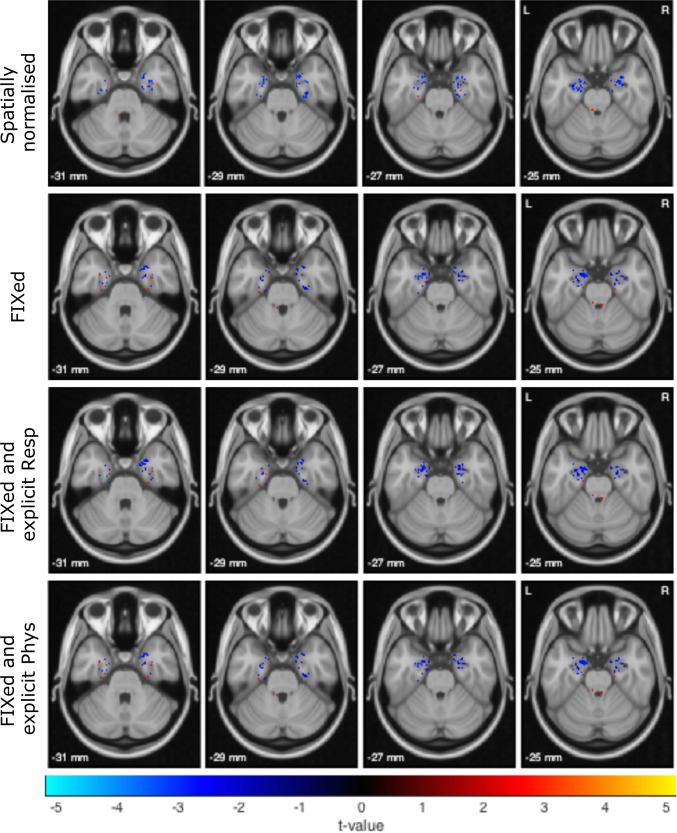
Functional connectivity from LC to MTL during consolidation compared to baseline across preprocessing steps.Note: Functional connectivity (FC) from LC component to medial temporal lobe regions during consolidation compared to baseline across preprocessing steps (t-values threshold at p<0.05, uncorrected for multiple comparisons). Significant clusters of lower FC between the LC and hippocampus and amygdala during consolidation as compared to baseline were observed across preprocessing steps except for the spatially normalized pipeline.